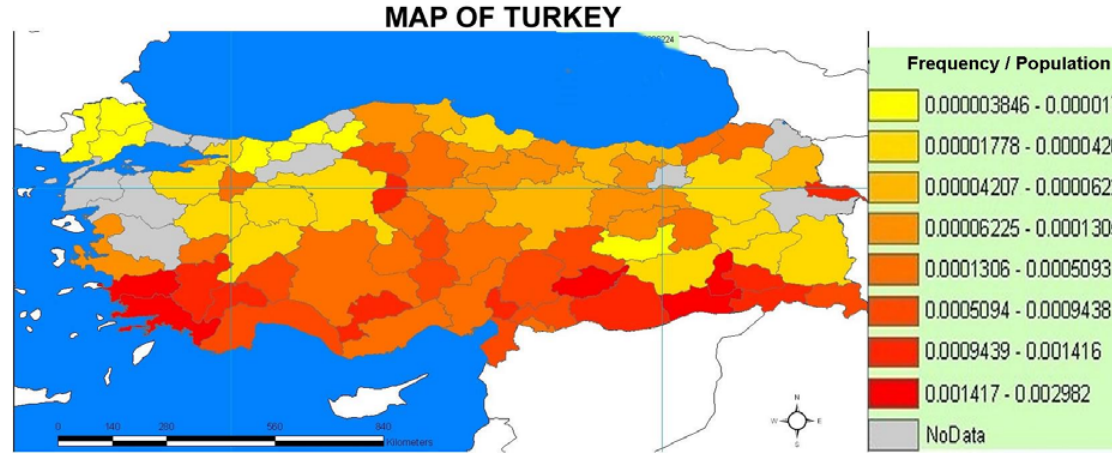
Figure 1. Distribution of scorpion stings according to the provinces of Turkey. The risk of scorpionism was assessed based on the sting frequency/population ratio.